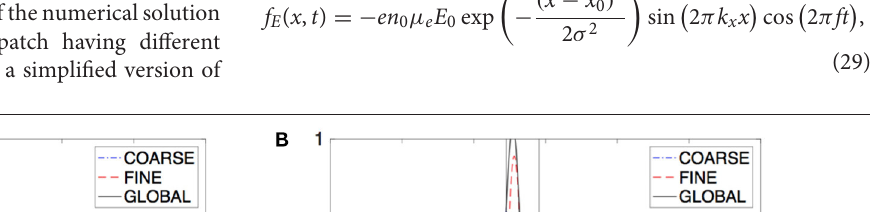
Frontiers in Physics |